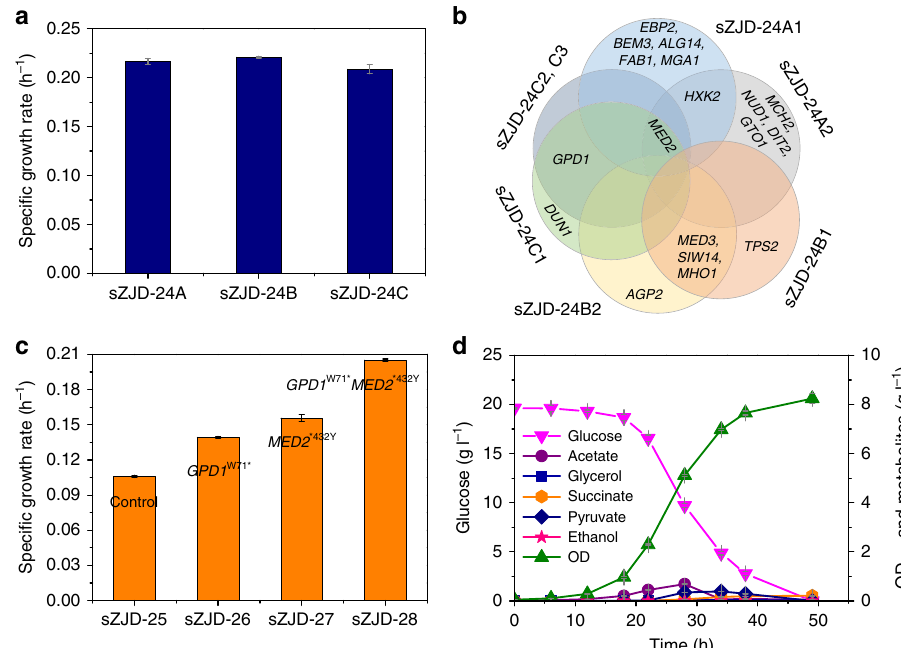
Fig. 2 Characterization of adaptive laboratory evolution strains and reverse engineered strains. a Determination of the speci fi c growth rate of evolved lines (sZJD-24A, sZJD-24B, and sZJD-24C) isolated at the end of the evolutionary experiment in 20 g l − 1 glucose minimal medium. b The genes with mutations identi fi ed in all of the isolated strains. sZJD-24A1 and A2 were from lines sZJD-24A, sZJD-24B1; B2 was from lines sZJD-24B, sZJD24C1; C2 and C3 were from line sZJD-24C. c Determination of the speci fi c growth rate of reverse engineered strains based on sZJD-23 in shake fl asks. d Growth and metabolite pro fi les of sZJD-28 in 20 g l − 1 glucose minimal medium. All data represent the mean ± s.d. of biological